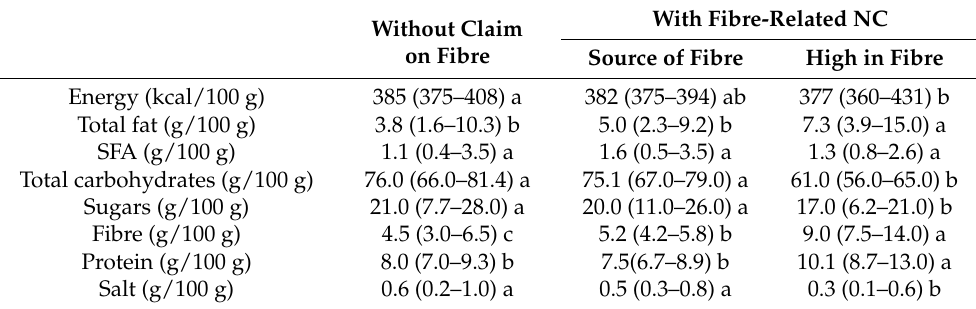
Legend: For each category, different letters in the same row after parenthesis indicate significant differences among types (Kruskal–Wallis test for independent samples with multiple pairwise comparisons, p < 0.05). Legend: NC, nutrition claim; SFA,